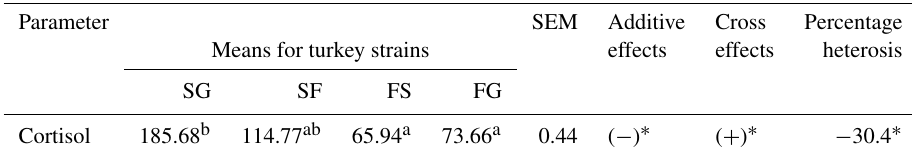
Table 4. Means, SEM and orthogonal contrasts on cortisol concentrations in serum (ngmL − 1 ) of female turkeys from different genetic